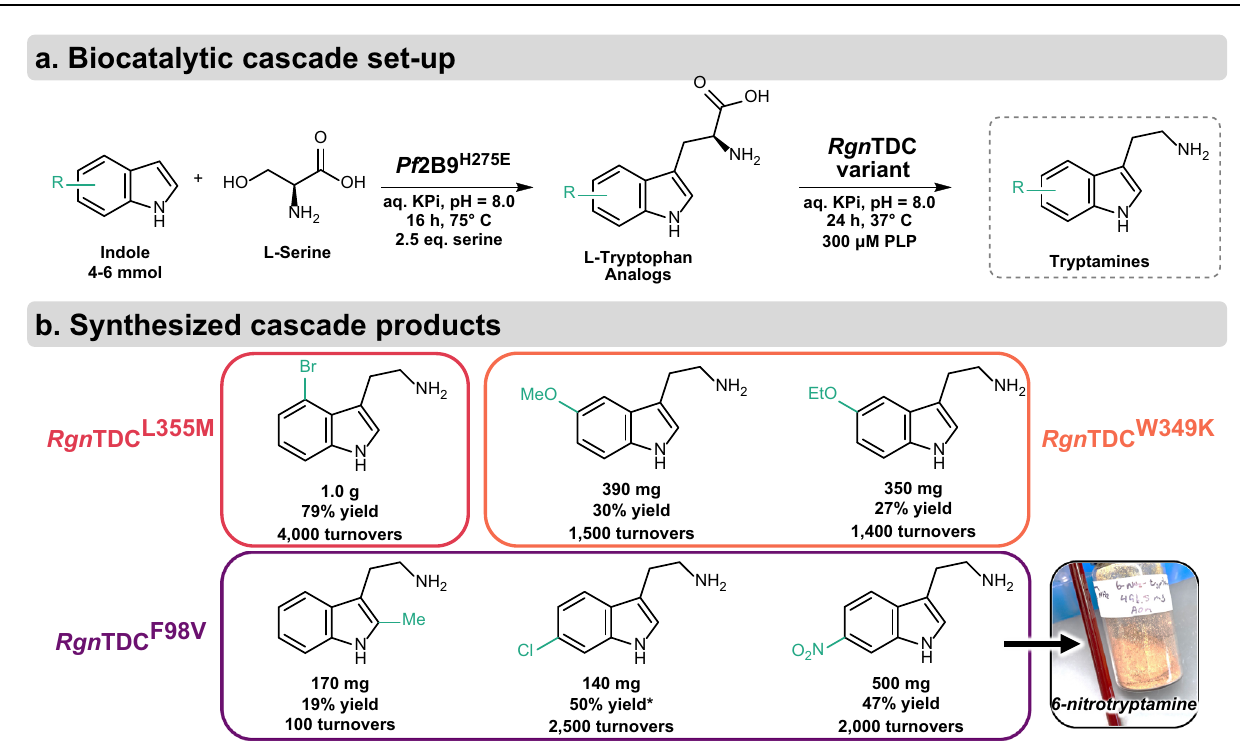
shows a dominant peak corresponding to E(A-A). A representative enzyme-only traceisshowninblack.Spectrawerecollectedat37°C. c X-raystructuresofH275E. i. Trp binding isshownin magentafrom PDB:7ROF.ii.4-Cl-Trp bindingisshownin cyan from PDB: 7RNP. Hydrogen and halogen bonds are shown in orange and purple dashes,